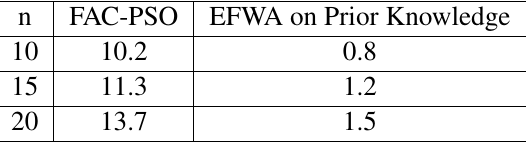
Table 2 Average computation time(s)